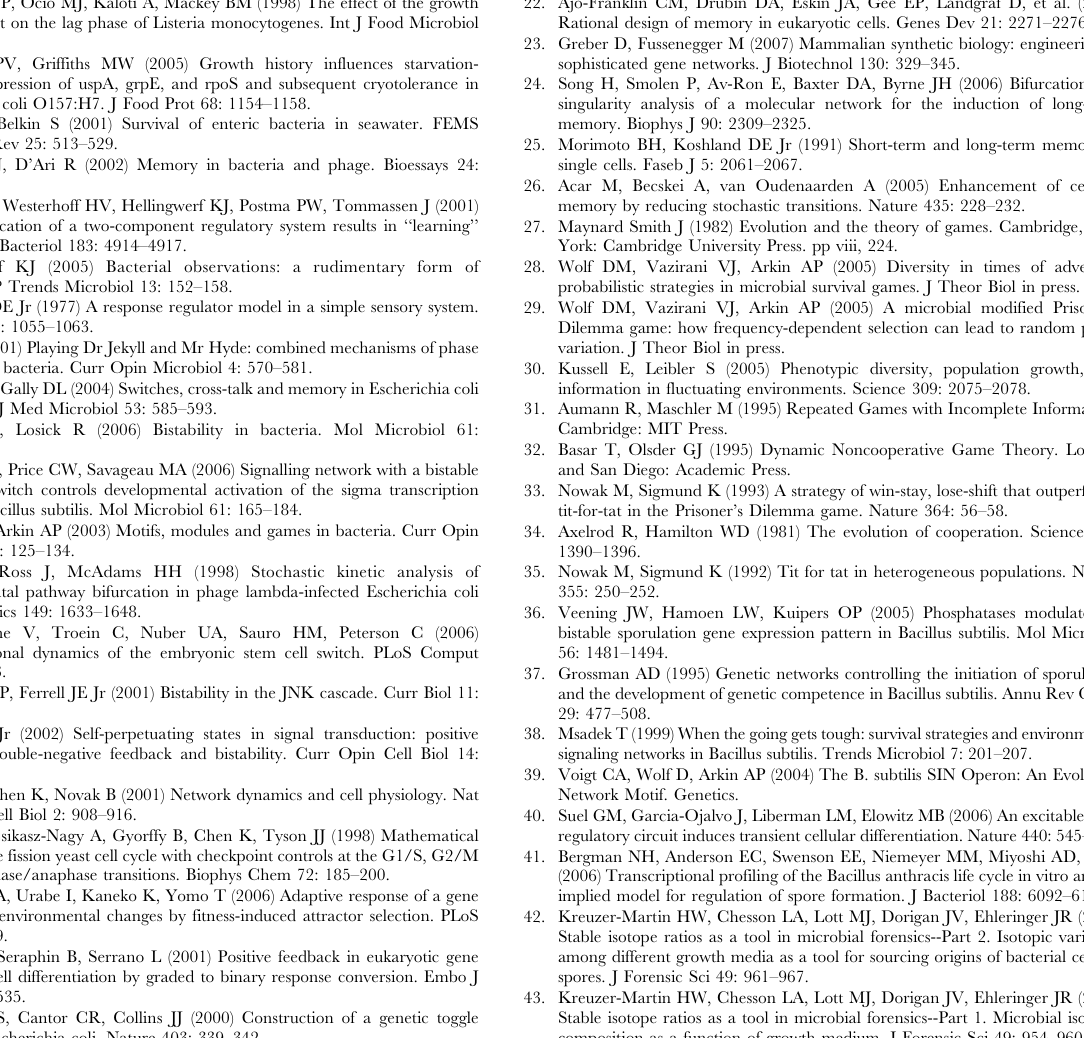
Figure S2 Sporulation initiation delay as a function of cell history.